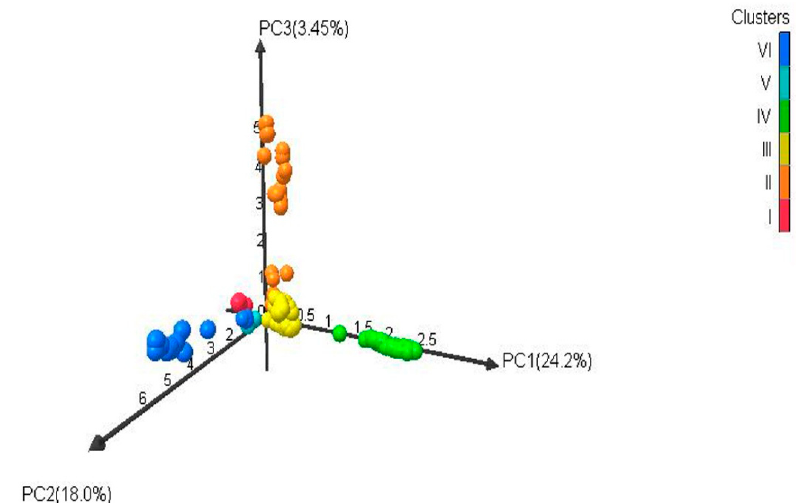
Figure 6. Three-dimensional principal coordinate analysis (PC O A) of a Gossypium accessions diversity panel genotyped with expressed sequence tags (EST) and Genomic simple sequence repeats (SSRs). The different colors in the figure correspond to six clusters: Red (Cluster I), orange (Cluster II), yellow (Cluster III), Bright green (Cluster IV), Sky blue (Cluster V), Blue (Cluster